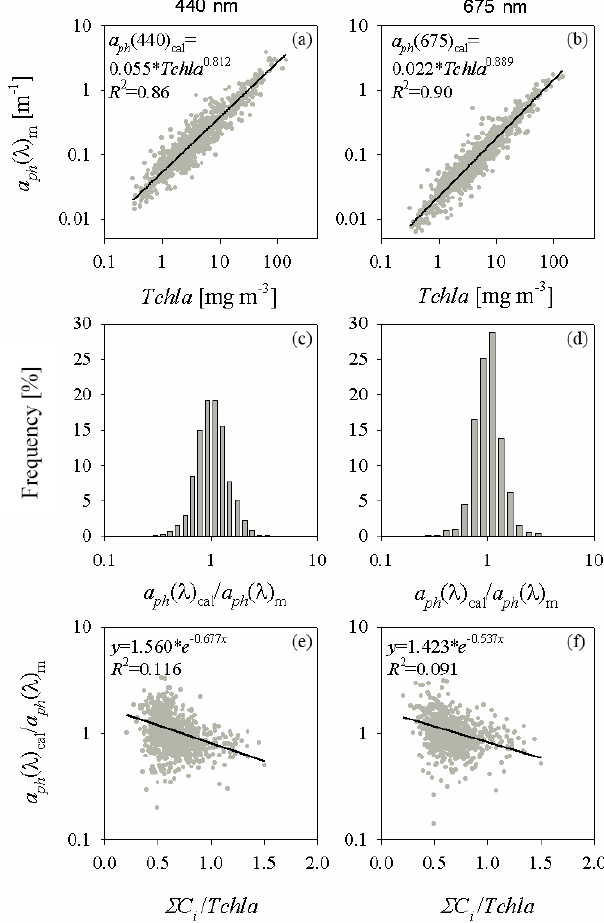
Figure B1. (a, b) Relations between measured coefficients of absorption by phytoplankton (denoted by a ph (λ) m ) and chloro- phyll a concentrations for two light wavelengths (400 and 675nm) and their functional approximations according to Eq. (3a) (the equations are given in the panels); (c, d) frequency distribu- tion histograms of the ratio of calculated and measured absorp- tion coefficients ( a ph (λ) cal /a ph (λ) m ) ; (e, f) relations between the ratio a ph (λ) cal /a ph (λ) m and the pigment concentration ratio (cid:54)C i / Tchl a and their functional approximations (the equations are given in the